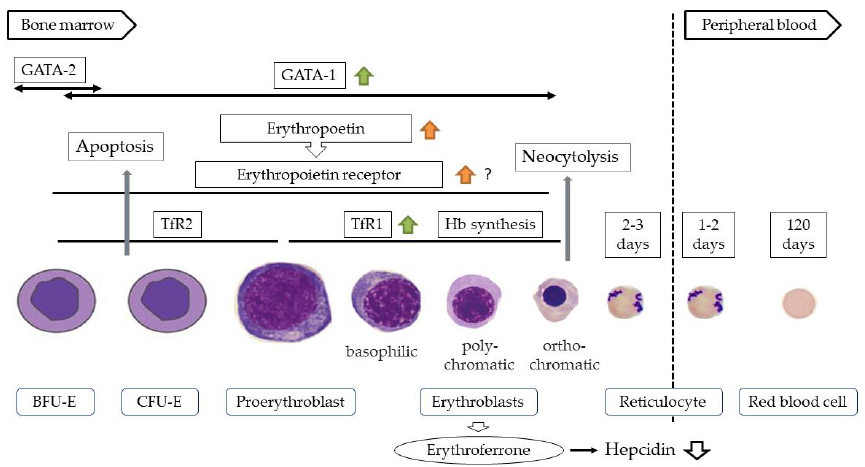
Figure 1. Differentiation process of erythroid cells. BFU-E, burst-forming unit-erythroid; CFU-E, colony-forming unit-erythroid.